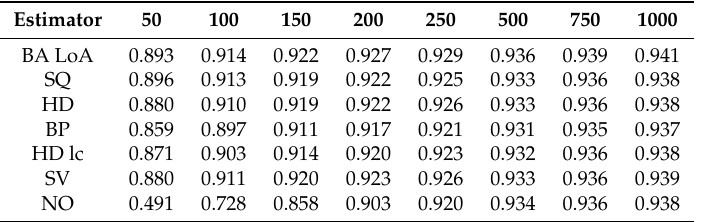
Table 1. Five percent quantiles of the coverage probability by the estimator and sample size n . For BA LoA, the 5% quantiles are shown assuming a standard normal distribution (benchmark